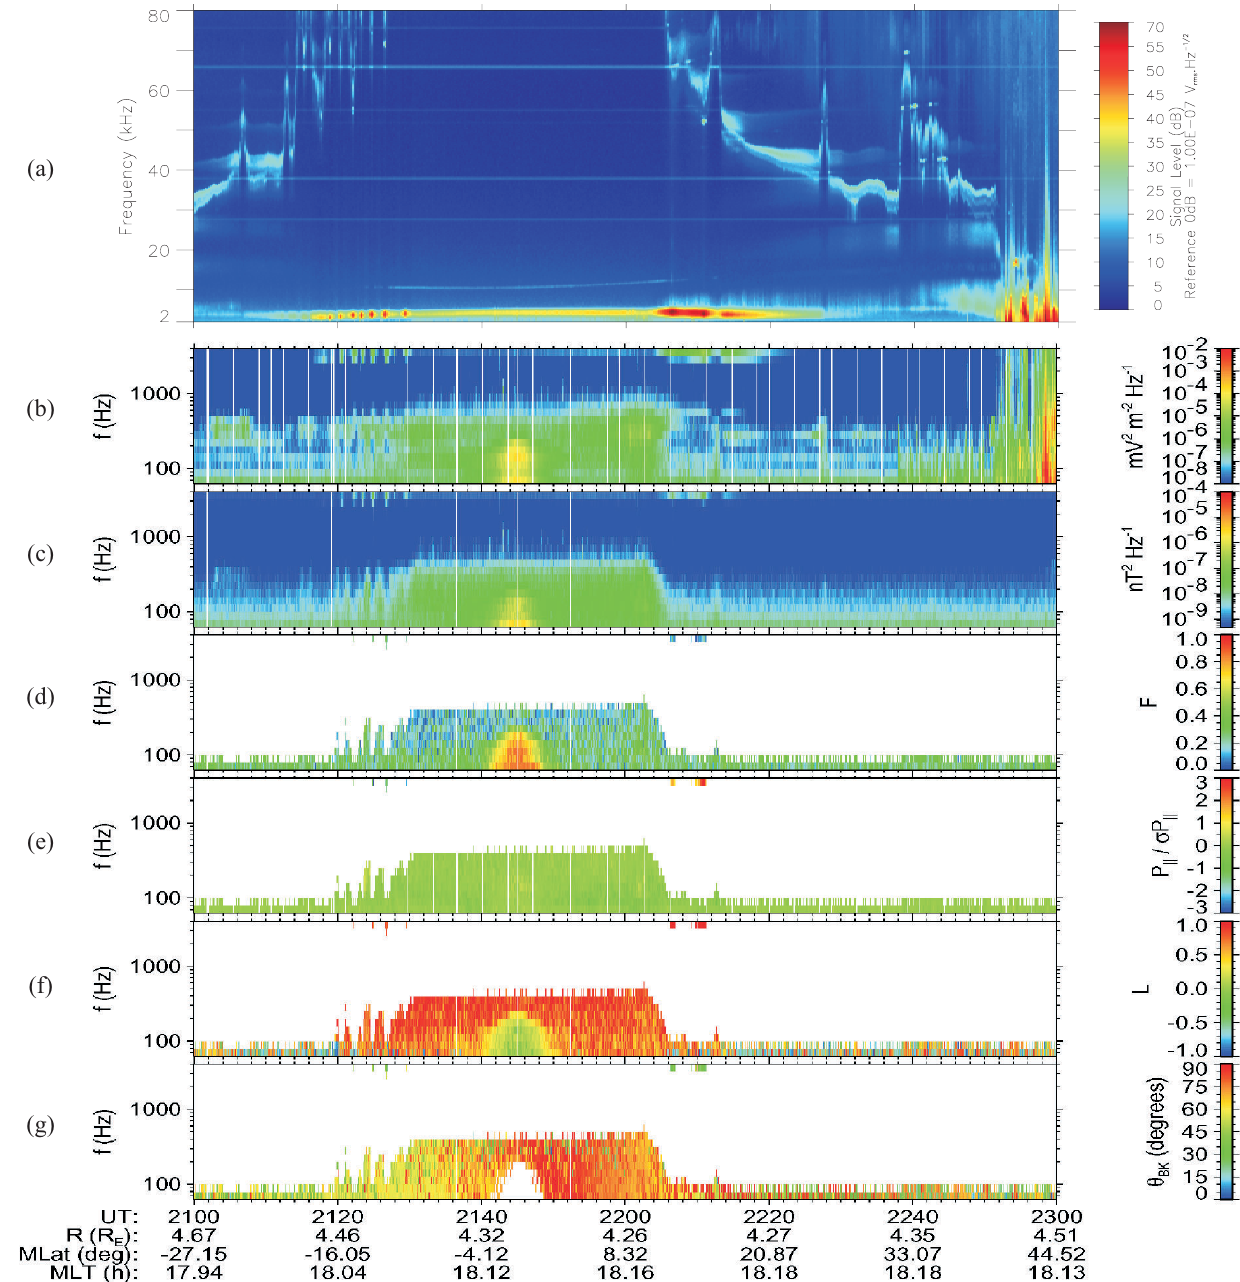
Fig. 5. WHISPER and STAFF data measured by C1 on 5 June 2001 from 21:00 to 23:00 UT. From top to bottom: electric field spectrogram in linear scale [2kHz, 80kHz], electric field spectrogram [60Hz, 4kHz] in logarithmic scale, magnetic field spectrogram [60Hz, 4kHz] in logarithmic scale, polarization planarity, parallel component of the Poynting vector normalized by its standard deviation, polarization ellipticity and the angle between the DC magnetic field and the wave normal